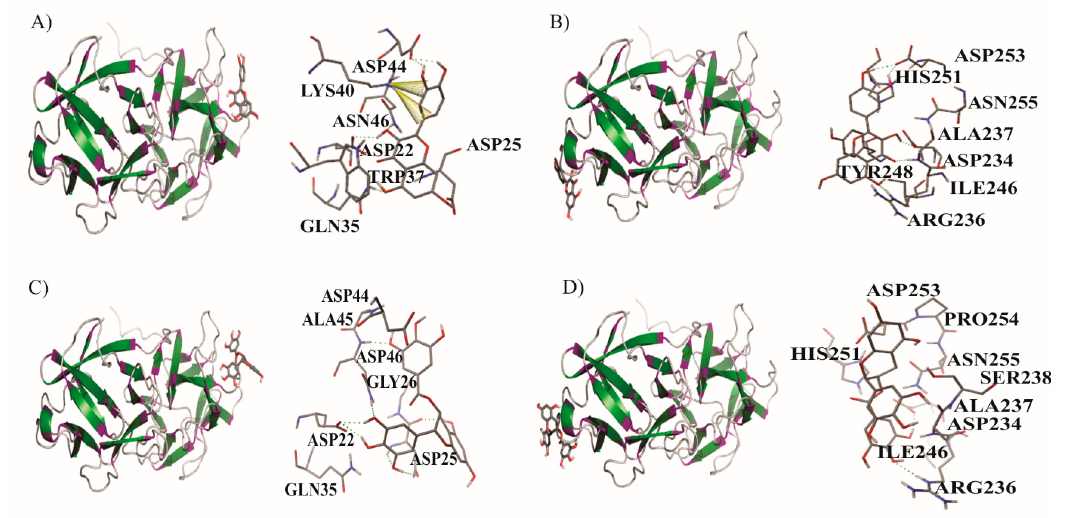
Figure 7. Detailed molecular interactions of quercetin (Q) and epigallocatechin gallate (EGCG) with the active sites of the B chain of the protein ricin. ( A ) Q with B 1 . ( B ) Q with B 2 . ( C ) EGCG with B 1 . ( D ) EGCG with B 2 .